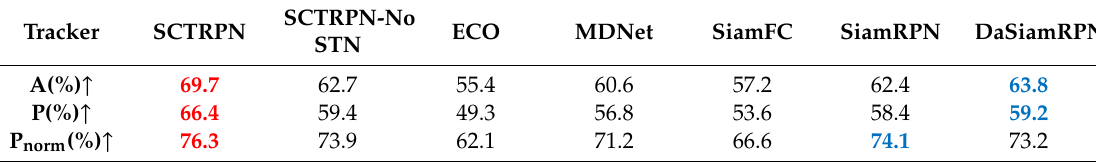
Table 4. Comparison on the TrackingNet in terms of success, precision, and normalized precision. The best two results are highlighted in red and blue fonts, respectively.